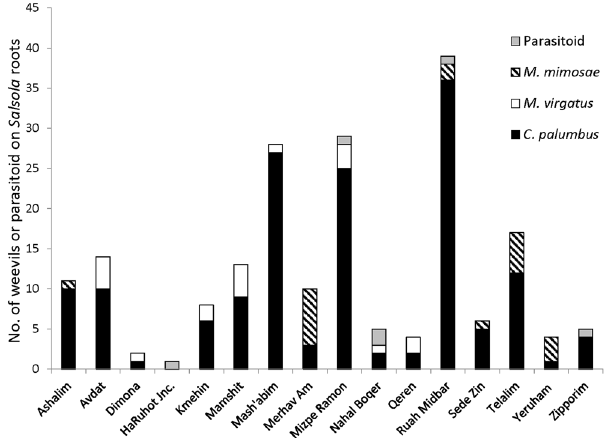
Figure 5. The distribution of the three weevil species and the parasitoid in the different field sites during the second survey